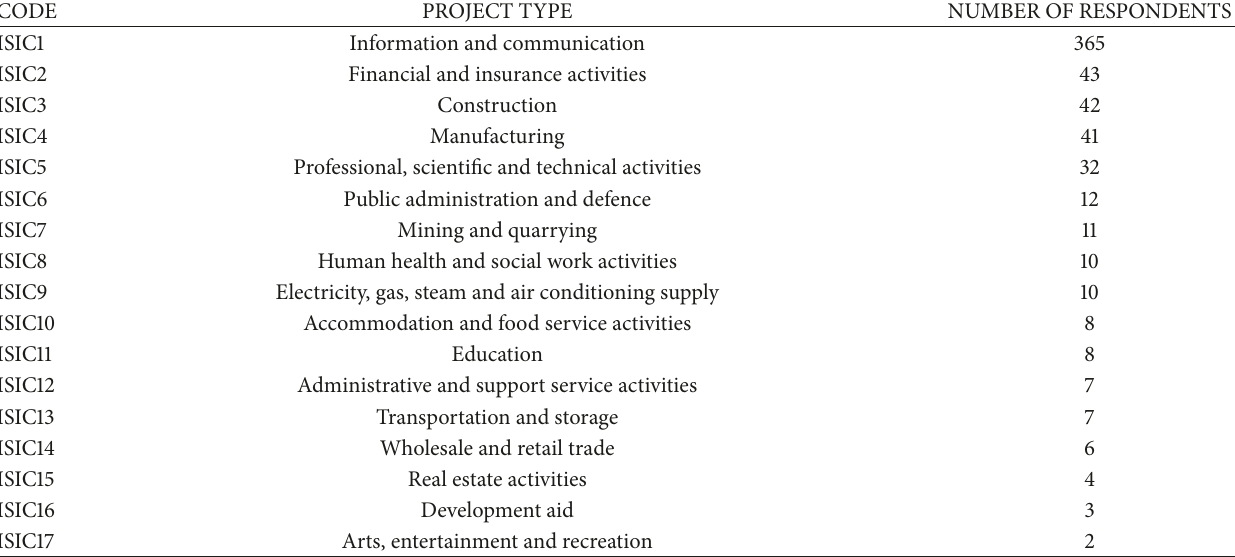
Table 5: Project types and number of responses.